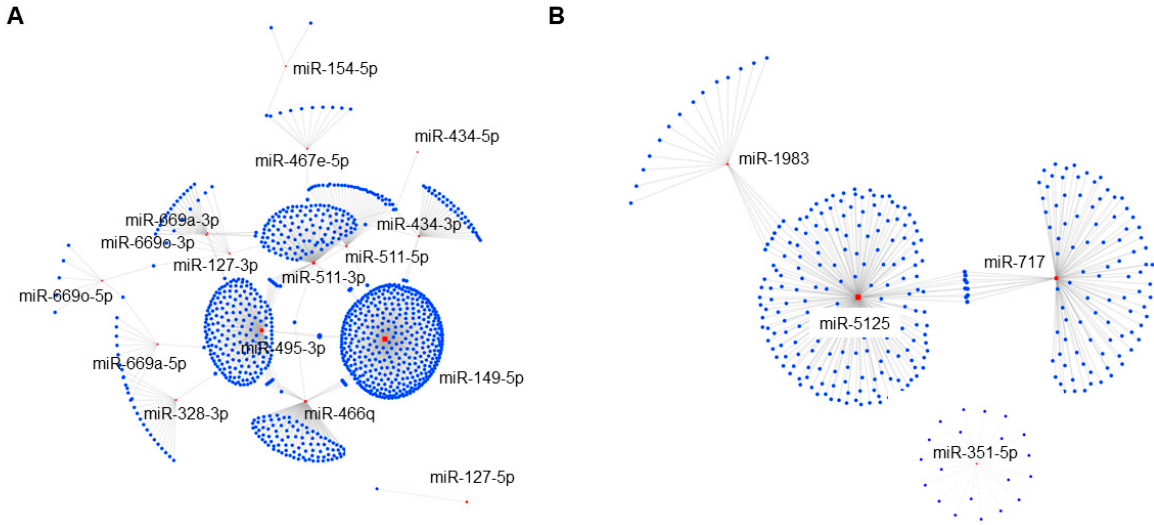
Figure 3. Sepsis-induced upregulated miRNAs exhibit more complex miRNA–mRNA regulatory networks in IECs. Putative miRNA–mRNA interaction networks of upregulated miRNAs ( A ) and downregulated miRNAs ( B ) in IECs with sepsis. Differentially expressed miRNAs and their predicted mRNA transcript targets are illustrated as networks across both upregulated and downregulated miRNAs with sepsis, in separate, as generated by an analytics platform, miRNet 2.0. Each individual node represents a miRNA (red) and an mRNA (blue), and grey lines signify a putative interaction. Relative sizes of miRNA and gene nodes depicted in the figure cannot be compared, as the interactive network analysis was run independently.